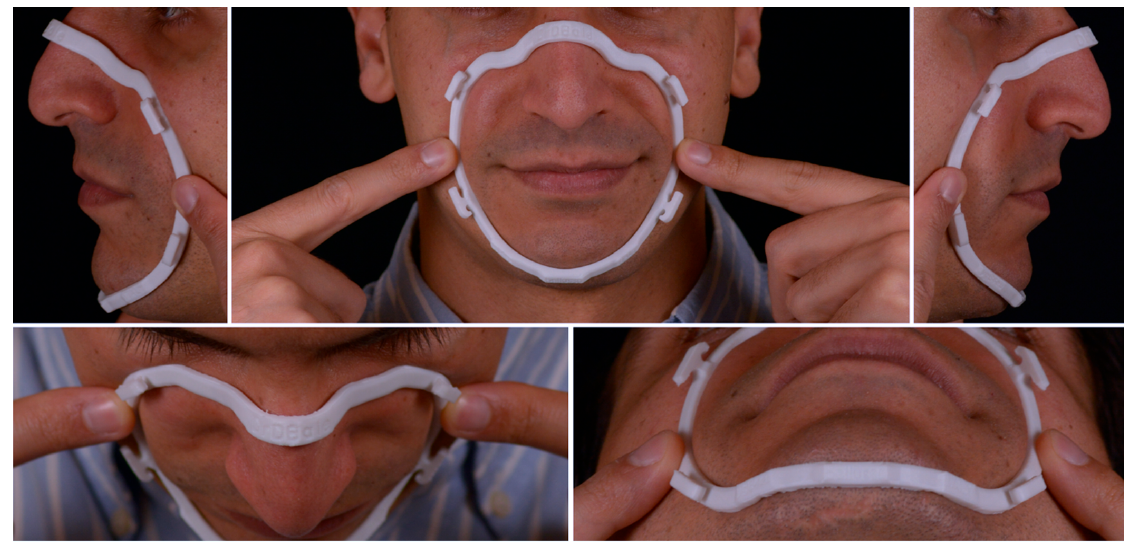
Figure 4. A 3D-printing process with a personal filament 3D-printer (left) and the Mask Fitter after printing and finishing.